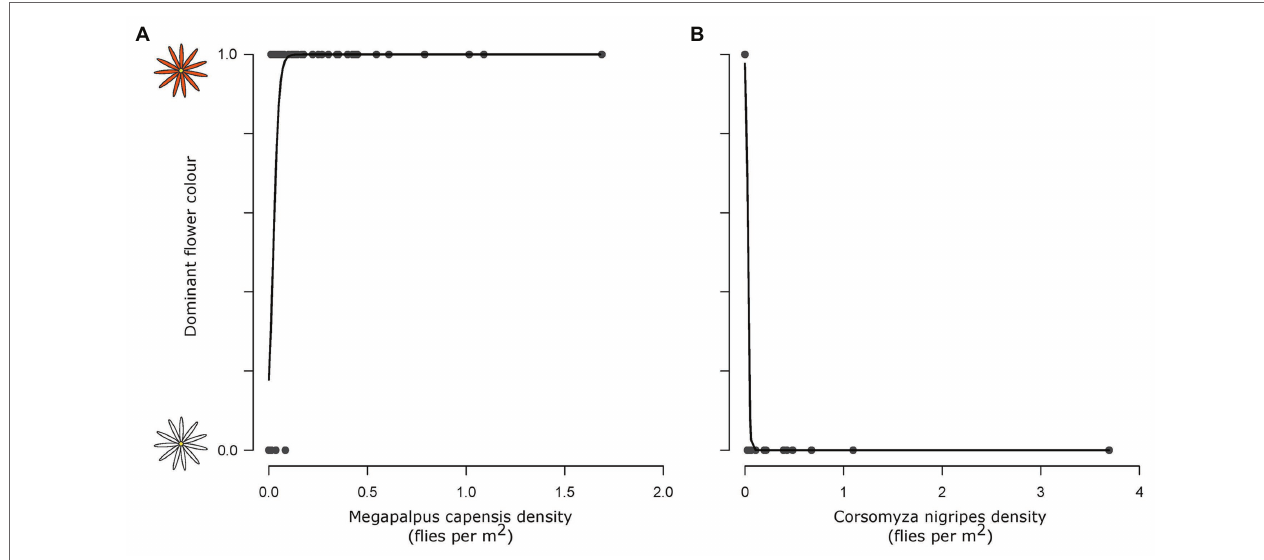
FIGURE 3 | The association between dominant flower color and pollinator species densities. Megapalpus capensis (A) and Corsomyza nigripes (B) densities predict flower color of Dimorphotheca and Ursinia species across 54 sites, where Megapalpus capensis is associated with orange flower dominance and Corsomyza nigripes is associated with white flower